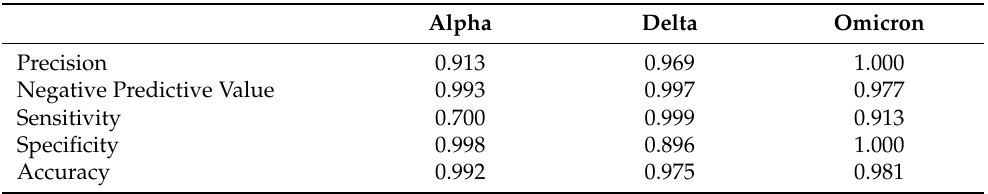
Table A2. Reporting the performance of the interval-based method for identifying SARS-CoV-2 variants versus the genetic sequencing on subsample 2670